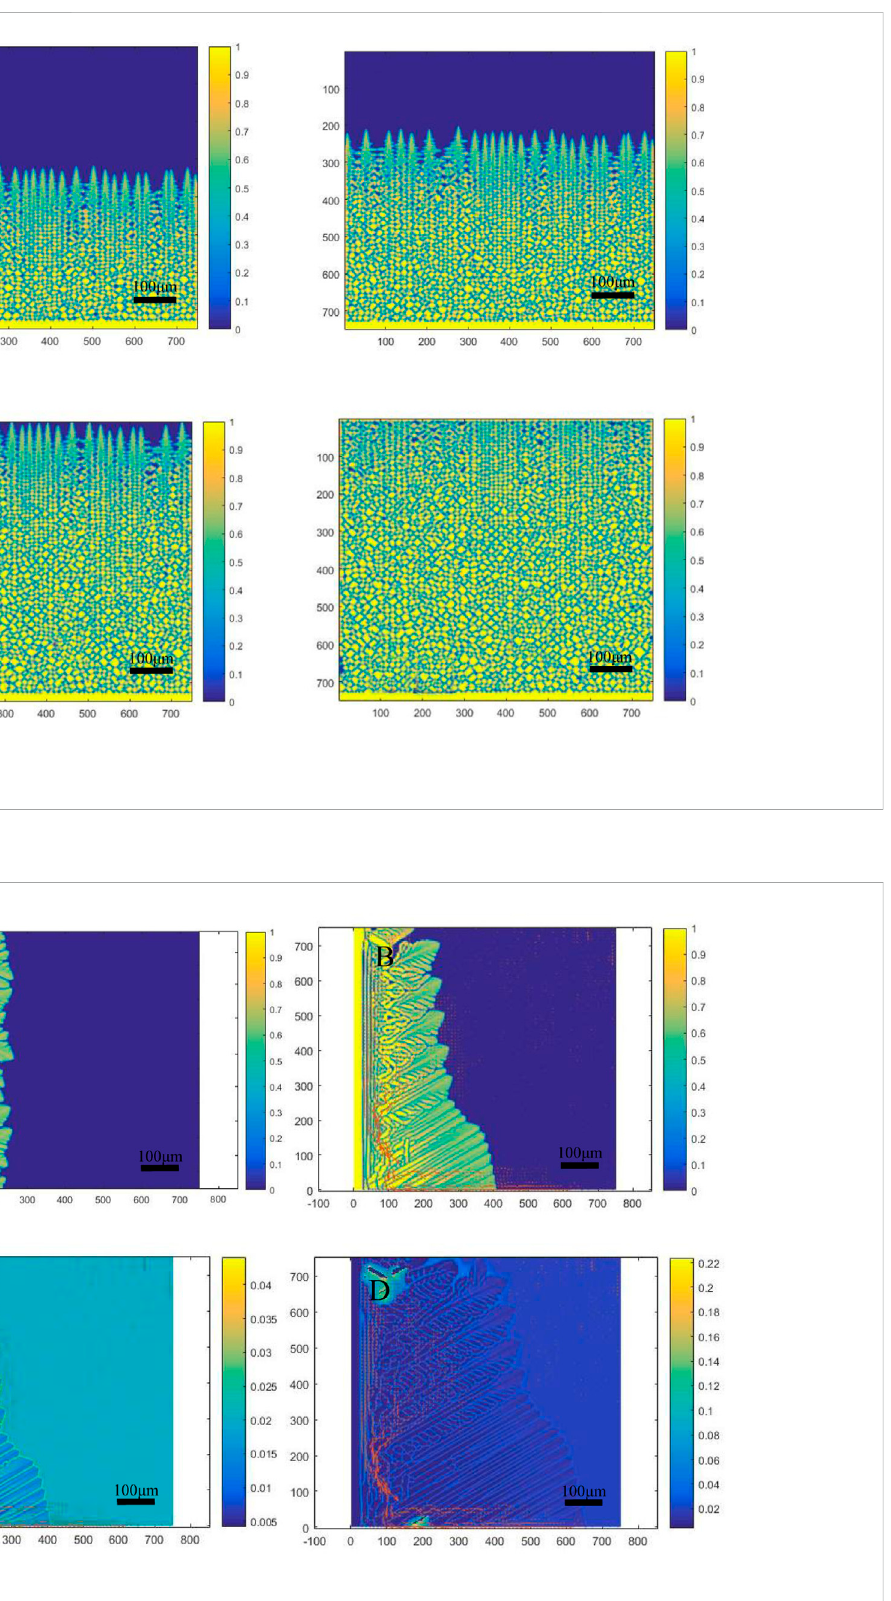
The simulation results of dendrites growth phase fi eld and solute fi eld of edge directional solidi fi cation under the condition of roll casting. (A,B) The simulation results of phase fi eld. (C,D) The simulation results of solute fi